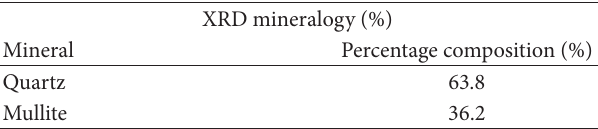
Table 8: Mineral composition of fly ash by